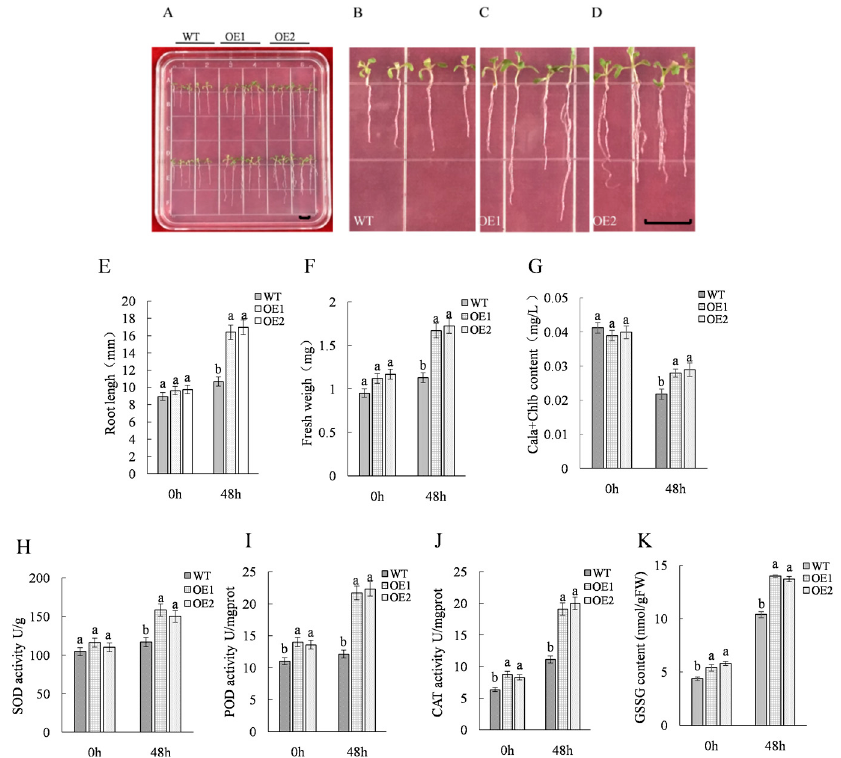
Figure 2. Analysis of Arabidopsis seedlings and determination of physiological indexes treated with 150mM NaCl. ( A ) Stress resistance analysis of Arabidopsis thaliana seedlings under NaCl stress. Bar 5 mm. ( B – D) are enlarged views of WT, OE1, and OE2 seedlings grown under 150 mM NaCl, respectively.